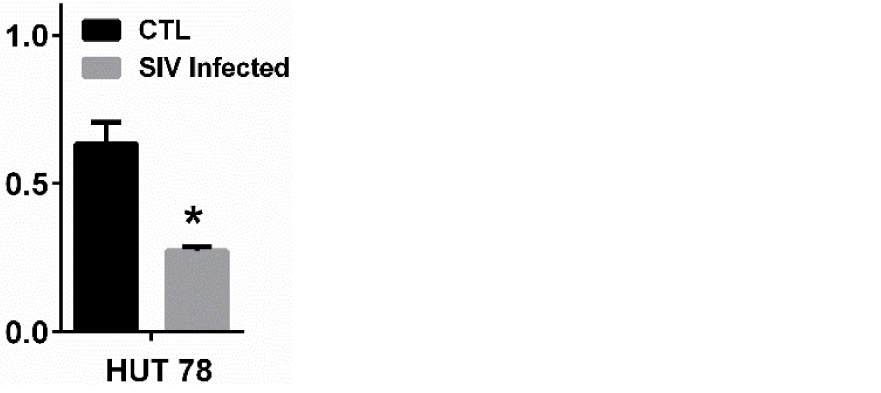
Figure 4. Effects of SIV Infection on RA production in CD4+ T cells . Hut78 cells (CD4+ T cells) or chronically SIV-infected Hut78 cells [86] were treated with 2 µ M retinol (substrate for RA synthesis) under serum free conditions for 4 h [87]. RA levels in cell pellets were quantified by LC-MS/MS [88]. SIV infection reduced the ability of Hut78 cells to make RA. * p <